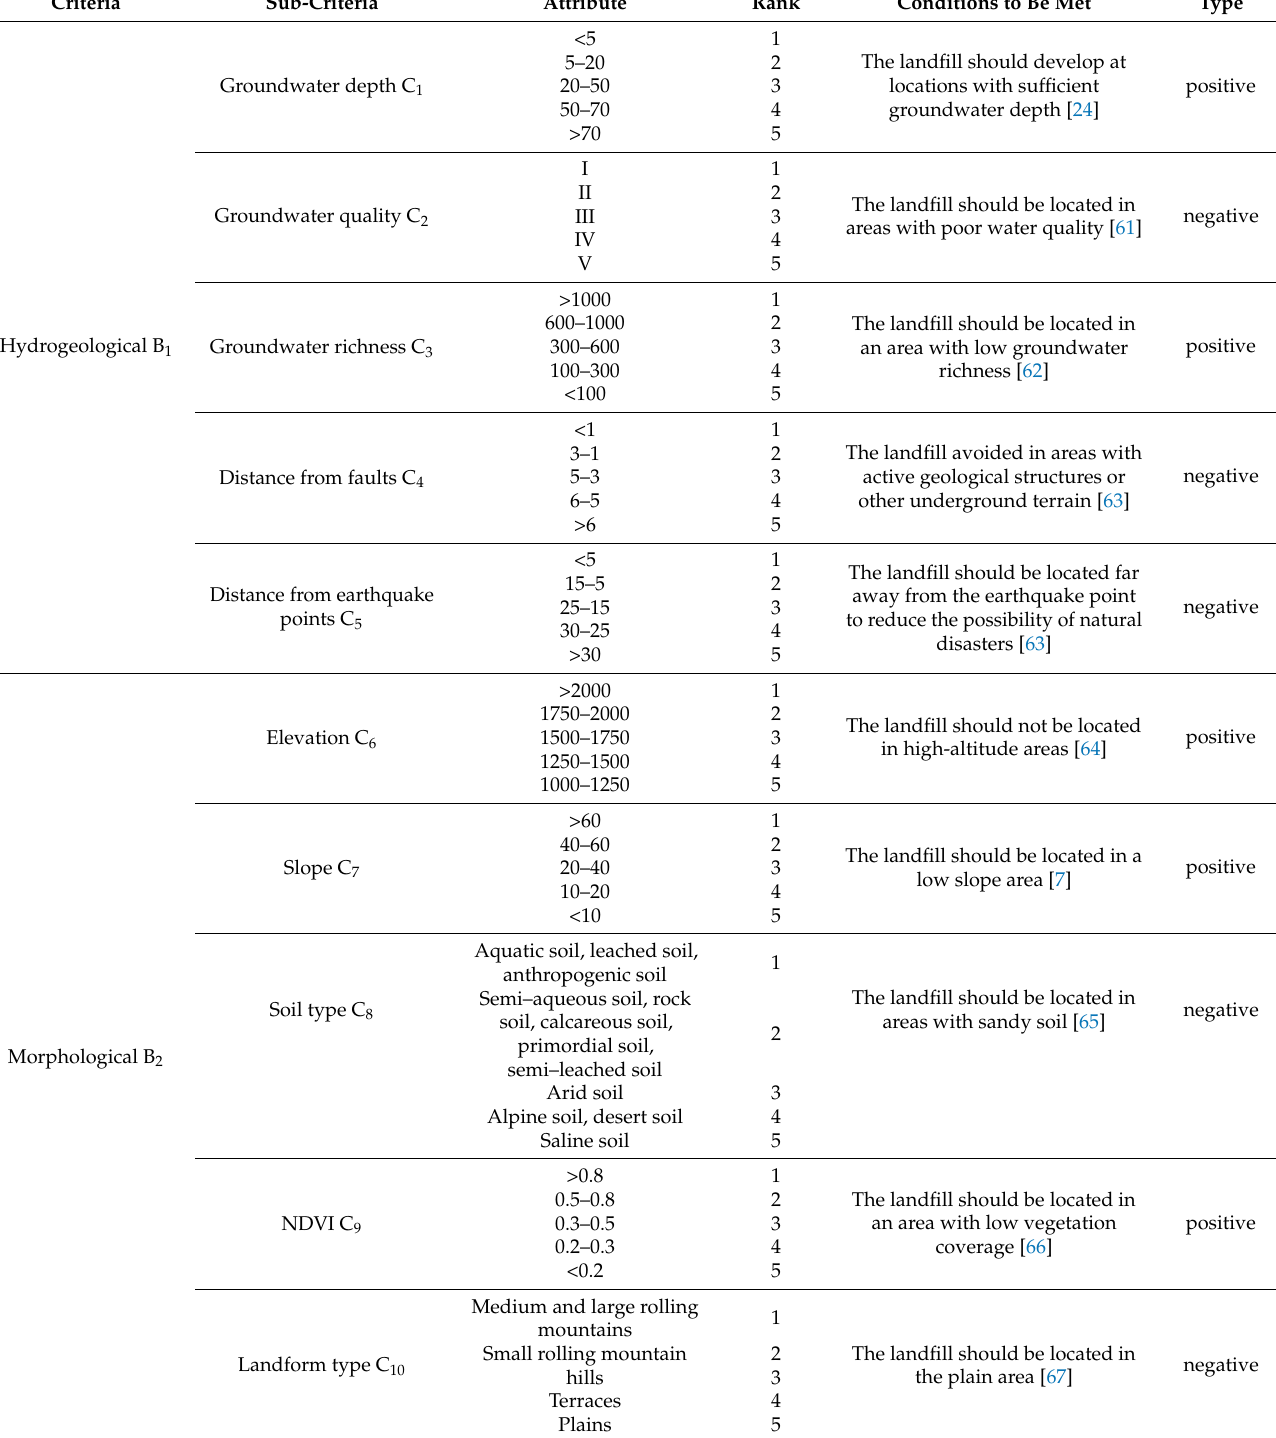
Table A2. Attributes, conditions to be met, and types of evaluation